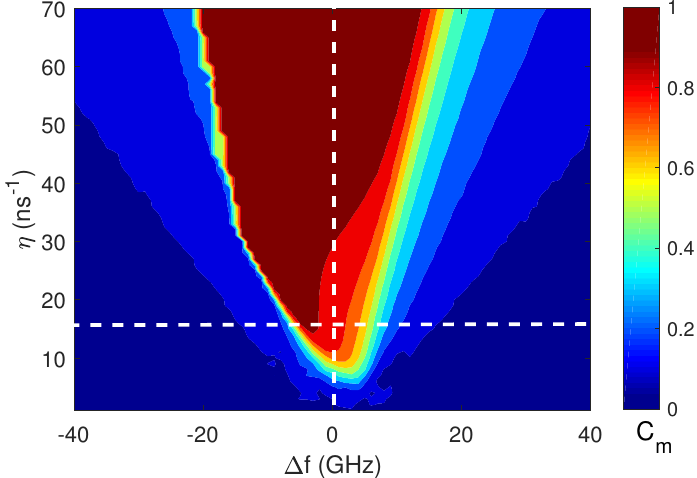
Figure 4. Maximum cross-correlation coefficient C m map in the injection parameters (frequency detuning ∆ f , injection rate η ) plane for keeping κ = 9 ns − 1 , τ ext = 10 ns, and τ f =